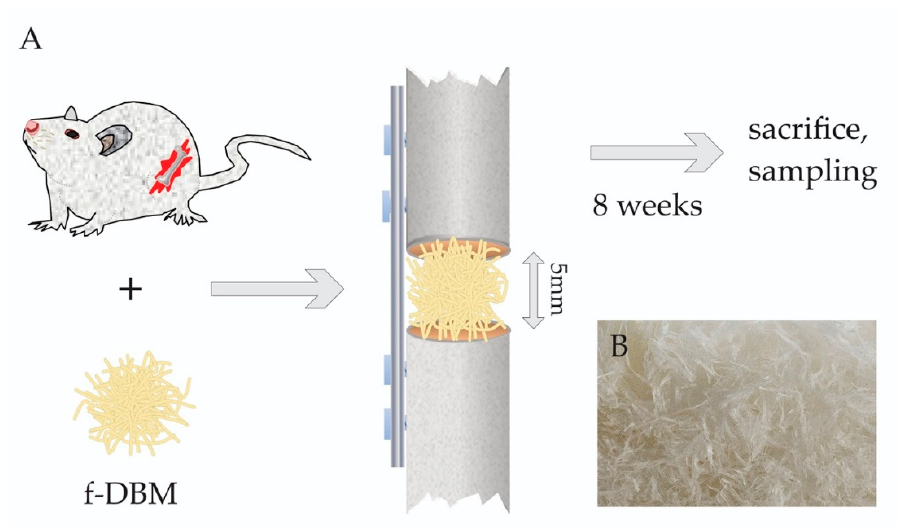
Figure 1. ( A ): Schematic of the experimental set-up: Implantation of fibrous-demineralized bone matrix (f-DBM) in 5 mm critical size femoral defects in Sprague-Dawley rats, which were sacrificed after 8 weeks. ( B) : Macroscopic image of the fibrous tissue scaffold.